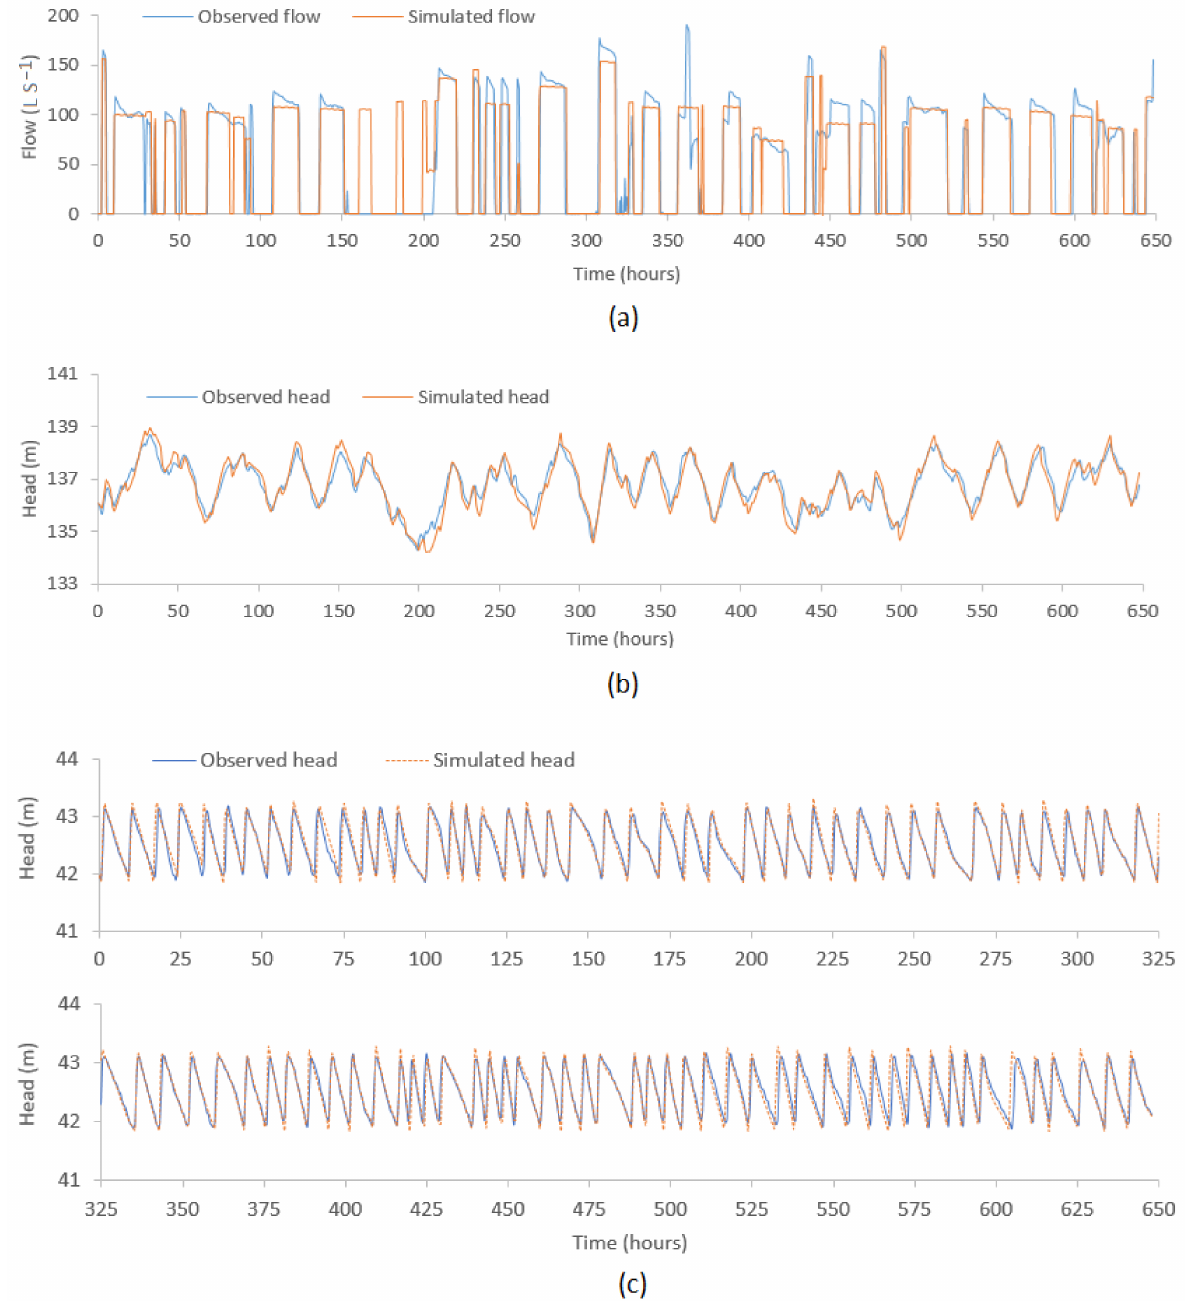
Figure 6. Plot of observed vs model simulated values ( a ) flow at PS2 ( b ) head at Binnies tank and ( c ) head at Meningie